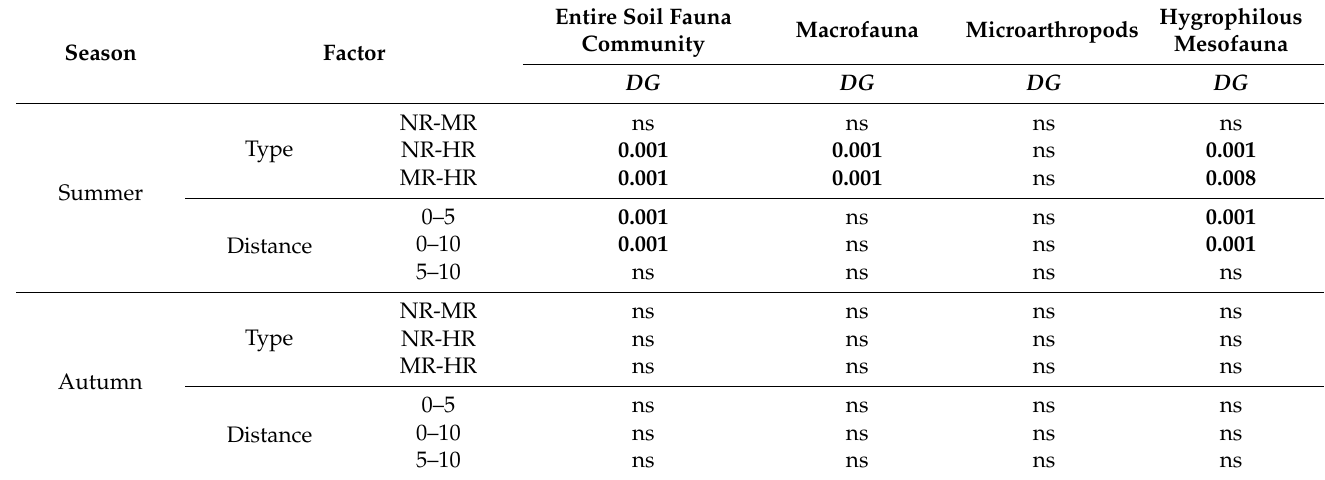
Table 2. Multiple comparisons of DG indices of soil fauna communities in different revetment types, distances, and seasons.